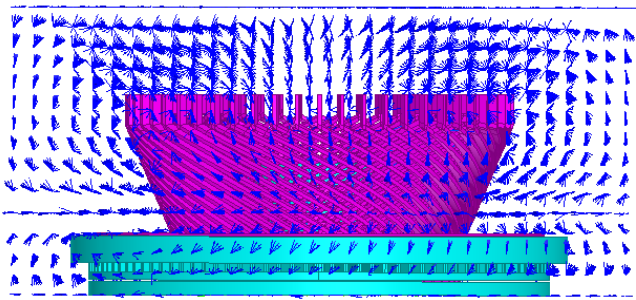
Figure 4. Leakage magnetic field.